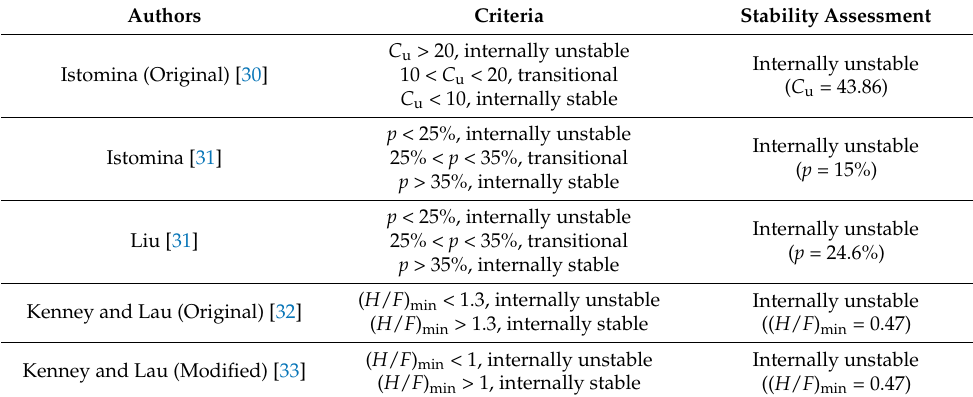
Table 5. Assessments of internal stability for the